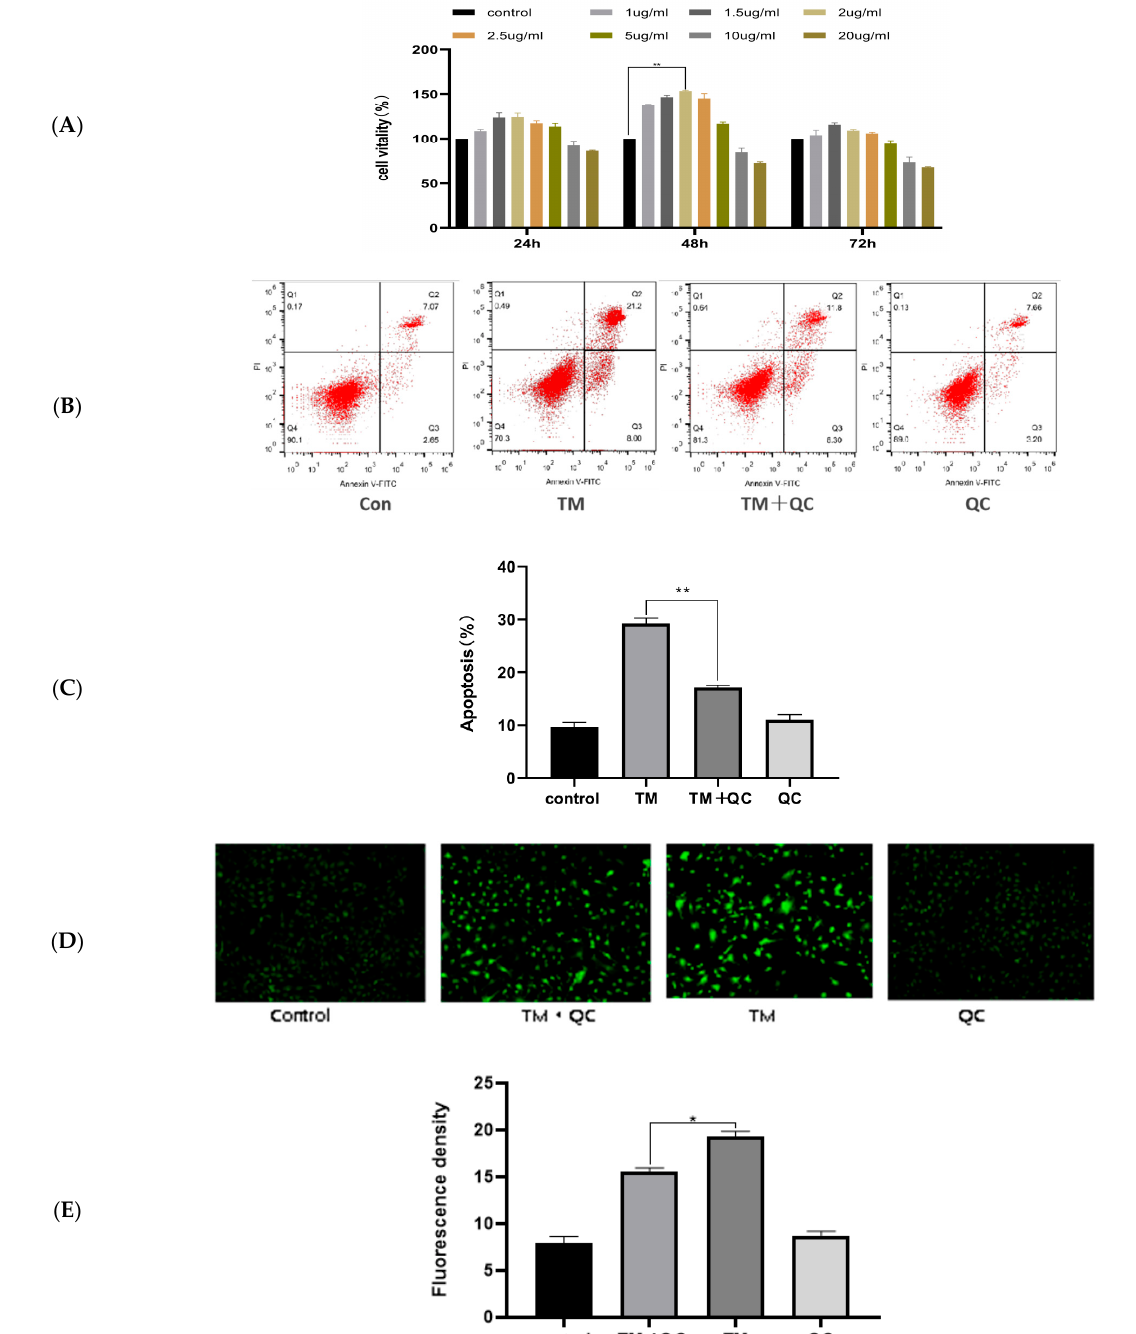
Figure 3. The effect of QC on TM-induced apoptosis in GCs. control: control group; TM + QC: pre-treated with QC, and then treated with TM; TM: TM alone treatment group; QC: QC alone treatment group: ( A ) The effects of different concentrations of QC treatment on cell viability for 24, 48, and 72 h. ( B ) The GCs were pretreated with QC for 8 h, and then treated with 2.5 μ g/mL TM for 40 h, and the apoptosis rate was detected by flow cytometry. ( C ) Statistics on apoptosis. ( D ) The intensity of intracellular ROS was examined using fluorescence microscopy. The higher the fluorescence intensity, the stronger the intracellular ROS activity. ( E ) Fluorescence Intensity Statistics. The asterisks refer to the level of significance (* p < 0.05, ** p < 0.01).Values are presented as means ± SD for 3 biological